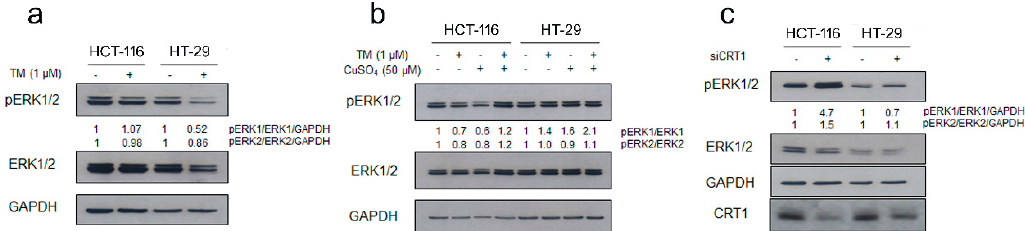
Figure 2. Copper chelation selectively affects MAPK signaling modulation in BRAF wt and BRAF V600E colon cancer cells. ( a ) BRAF wt (HCT-116) and BRAF V600E (HT-29) (1.5 × 10 5 cells/60 mm dish) were